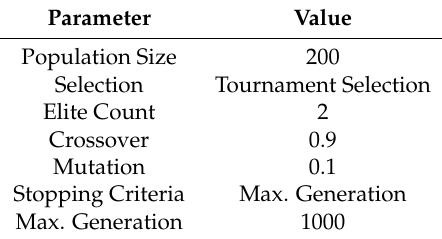
Table 10. GA parameters and values.